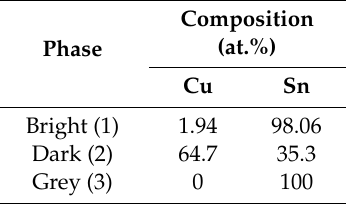
Table 3. Compositional analysis of Sn-0.7 wt. %Cu milled powder.